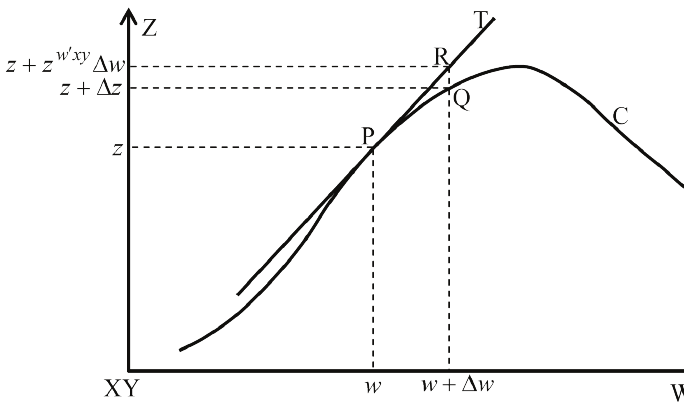
Figure 1 A property z is expressed as a function z wxy of three in- dependent parameters, w , x , and y . Here the dependence of z on w for some fixed values of x and y is shown by means of curve C. In particular, an increment w ∆ in w results in an increment z ∆ in z . The increment in w takes one from point P on C to point Q. T is the tangent to C at point P. Its slope is the derivative of xy . It is also the sensitivity of z z wxy with respect to w , that is, z w xyw z ′ xy wz xyw ∆ ′ is an estimate to change in w with x and y held fixed. z w xyw z ′ of z ∆ (Equation